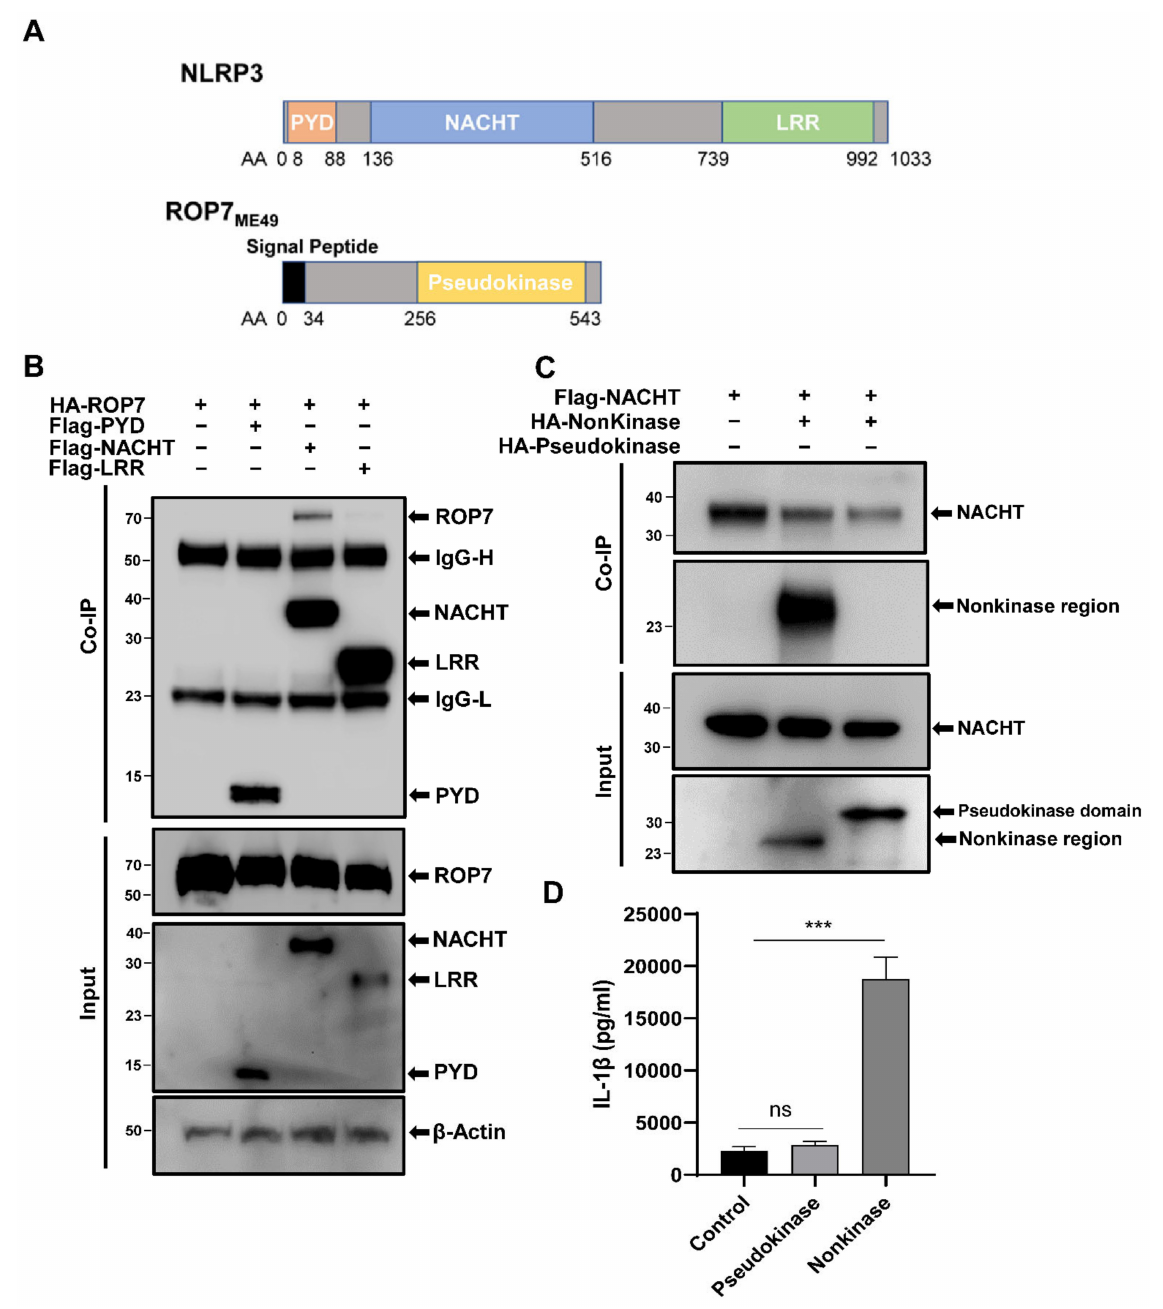
Figure 2. The interaction of NLRP3 and ROP7 domains in 293T cells. ( A ) Schematic structure of NLRP3 and ROP7. ( B ) The 293T cells were transfected with pcDNA3-HA-ROP7 in combination with pCMV-Tag2B-PYD, pCMV-Tag2B-NACHT, or pCMV-Tag2B-LRR. The cell lysates were immunopre- cipitated using an anti-Flag antibody and further analyzed by immunoblotting using an anti-Flag anti- body (PYD/NACHT/LRR) and an anti-HA antibody (ROP7). ( C ) The 293T cells were transfected with pCMV-Tag2B-NACHT in combination with pcDNA3-HA-nonkinase or pcDNA3-HA-Kinase. The cell lysates were immunoprecipitated using an anti-Flag antibody and further analyzed by immunoblot- ting using an anti-Flag antibody (NACHT) and an anti-HA antibody (nonkinase/pseudokinase). ( D ) The 293T cells were co-transfected with inflammasome-component plasmids and ROP7 pseudok- inase domains, nonkinase regions, or empty plasmids. The IL-1 β secretion in cell-free supernatant was measured after 36 h. Data are expressed as mean ± SEM values. ns: non-significant, *** p < 0.001, as compared with the empty vector